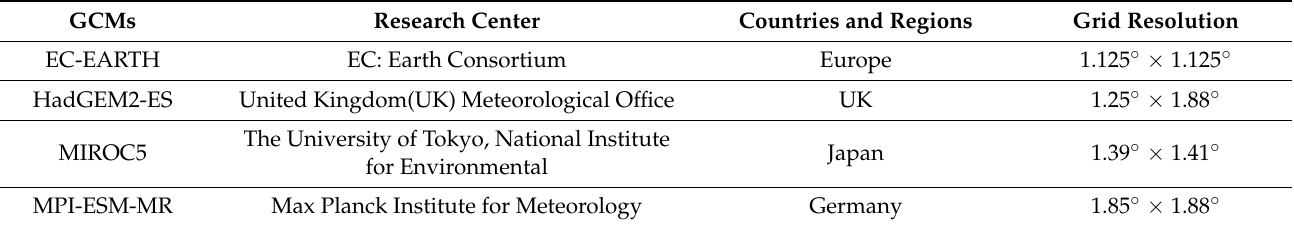
Table 2. 4 GCMs datasets in the LARS-WG